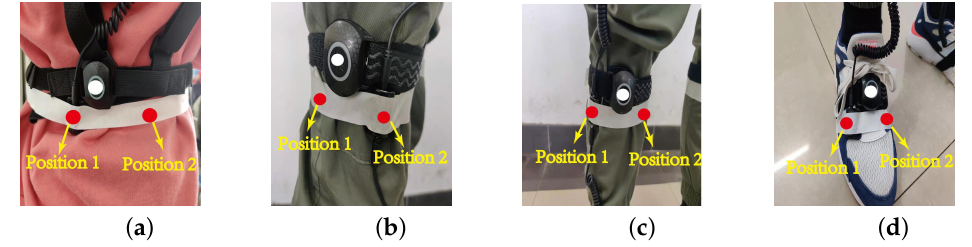
Figure 8. The IMUs are mounted in position 1 and position 2 for the experiment, respectively. ( a ) The waist; ( b ) the upper leg; ( c ) the lower leg; ( d ) the